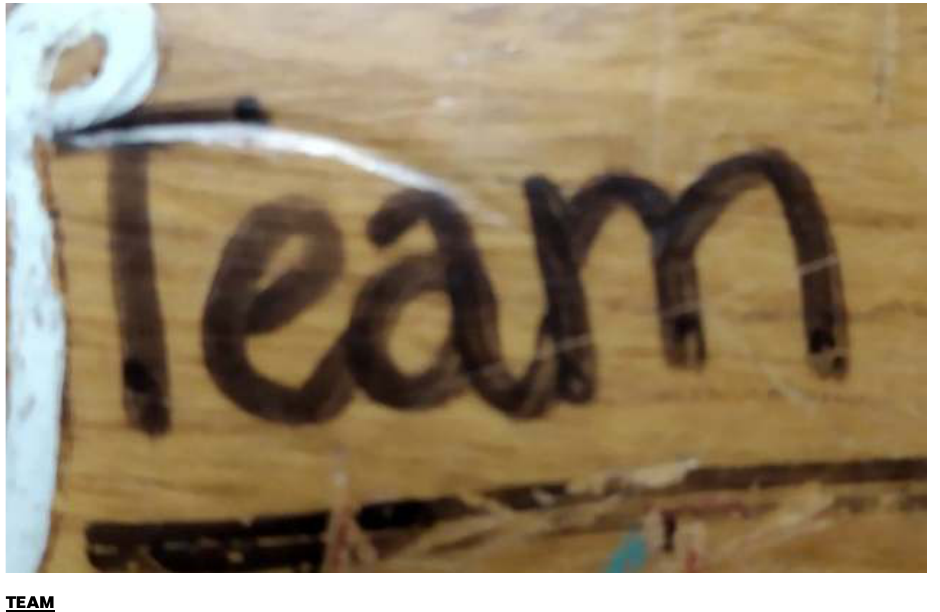
Team Photo: J. Peake.